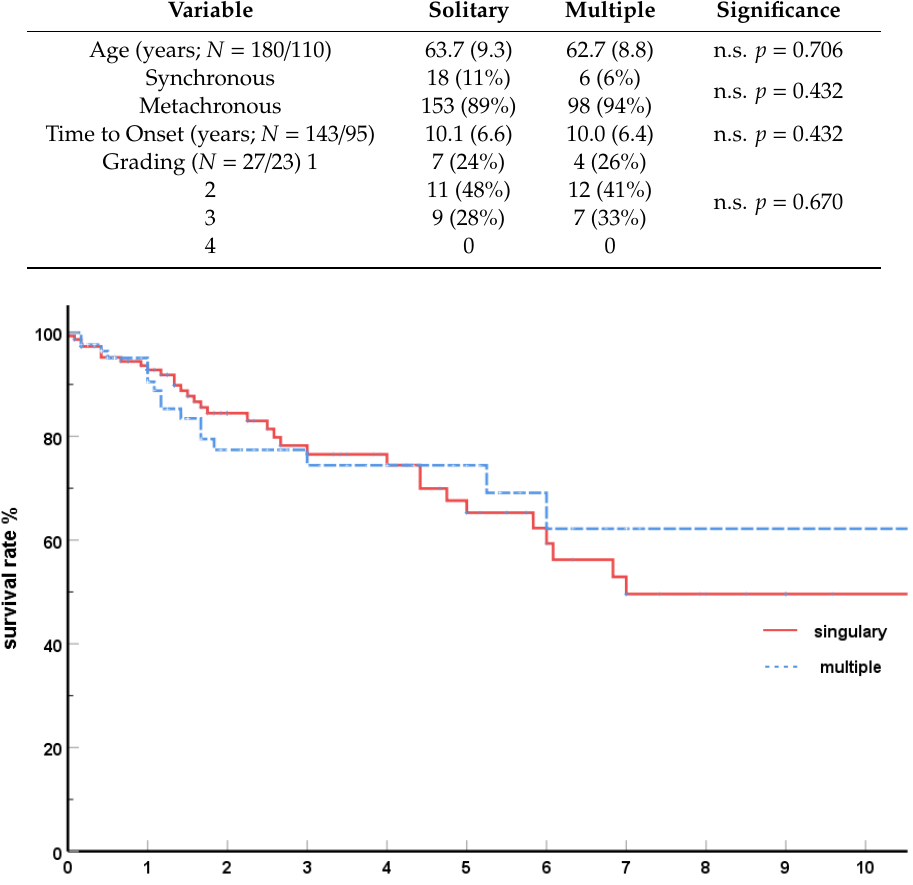
Table 2. Solitary vs. multiple isolated pancreatic metastases renal cell carcinoma (standard deviation of mean).